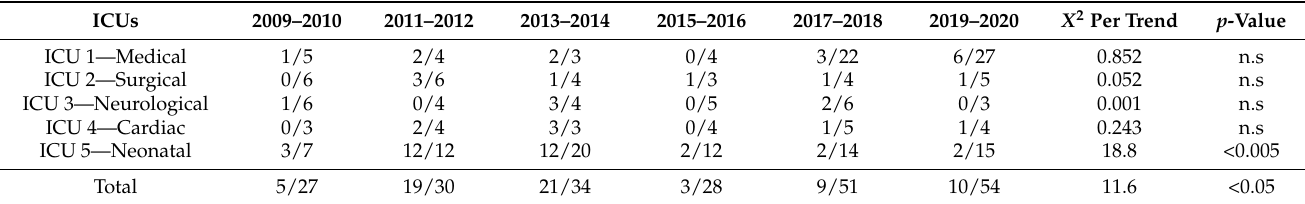
Table 3. Temporal trend of contaminated air samples in each ICUs.